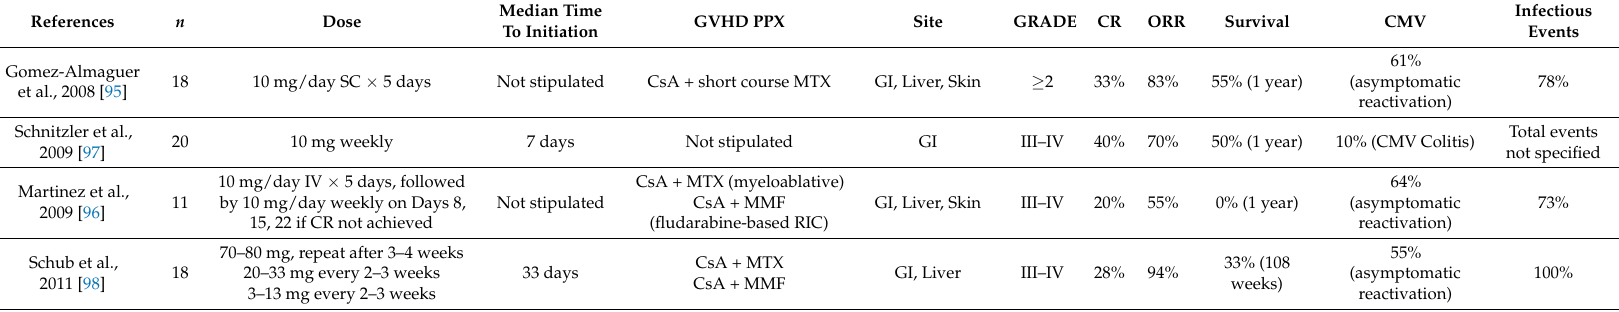
Table 5. Comparison among various clinical trials on the use of alemtuzumab for the management of steroid refractory acute